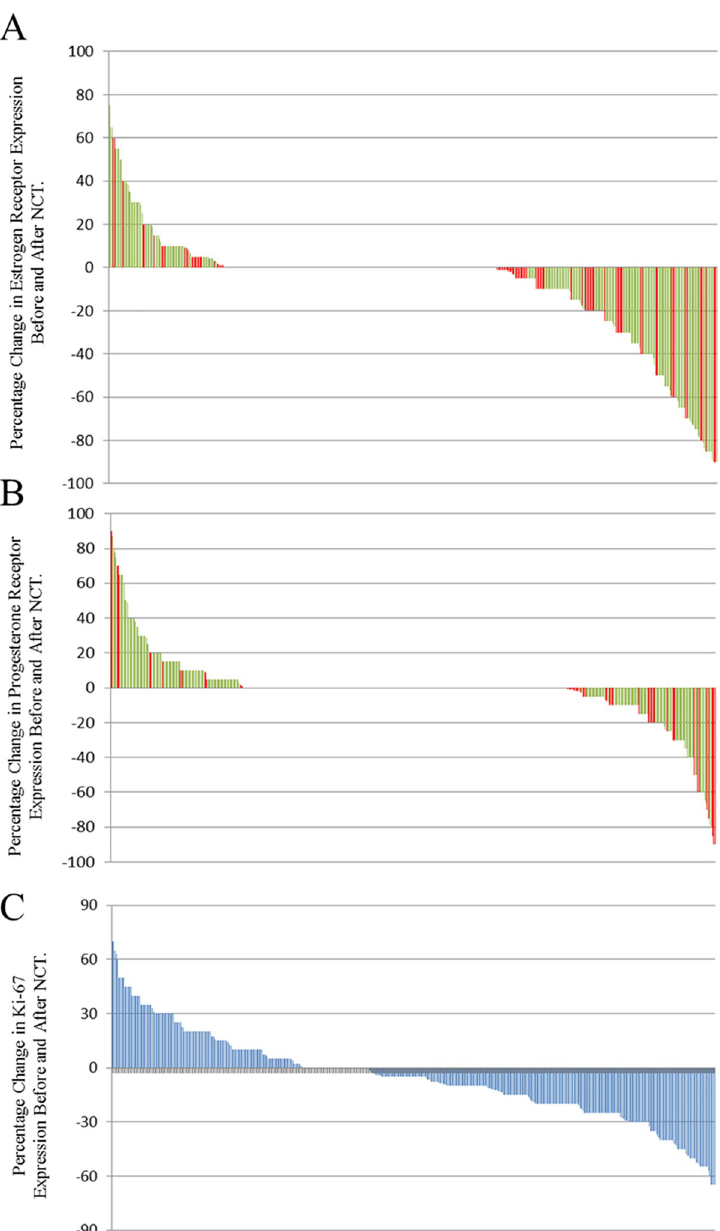
Fig 2. Waterfall plot showing the quantitative changes in ER, PR, and Ki-67 expression. Positive scores represent an increase in receptor expression before and after NAC; negative scores represent a decrease in receptor expression. Green, concordance with the primary tumor; Red, discordance with the primary tumor. (A) ER discordance rate: 10.4% (50/482) of patients, including 36 (7.5%) patients with positive-to-negative conversion and 14 (2.9%) patients with negative-to-positive conversion; (B) PR discordance rate: 17.0% (82/482) of patients, including 57 (11.8%) patients with positive-to-negative conversion and 25 (5.2%) patients with negative-to-positive conversion; (C) Ki-67 discordance rates: 50.4% (243/448) of patients had decreased expression and 27.0% (130/448) of patients had increased expression.